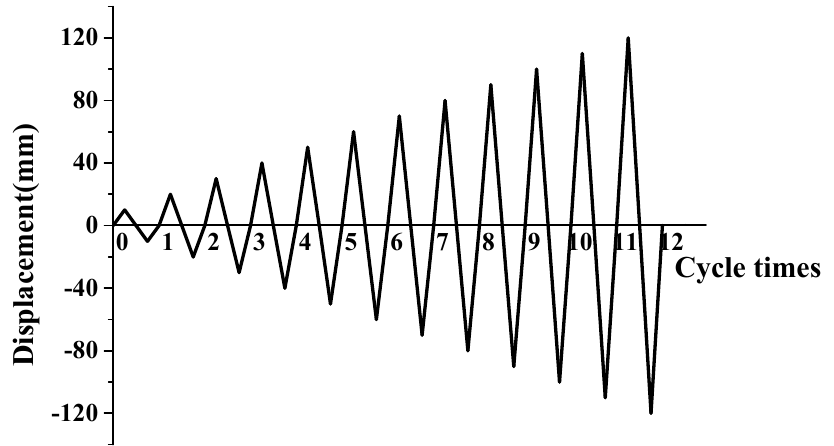
Figure 15. Test setup and loading programme.